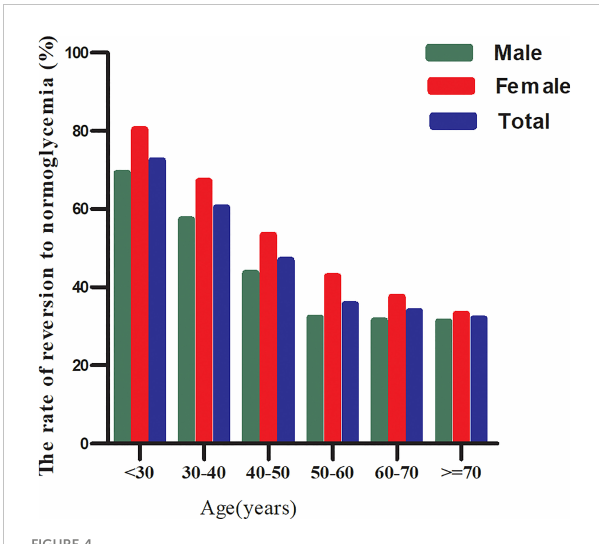
FIGURE 4 The rate of reversion to normoglycemia in IFG patients of age strati fi cation by 10 intervals. Figure showed that the rate of reversion to normoglycemia among participants with IFG was higher in women than in men, regardless of their age group. It was also found that the reversal rate decreased with age in both men and women.